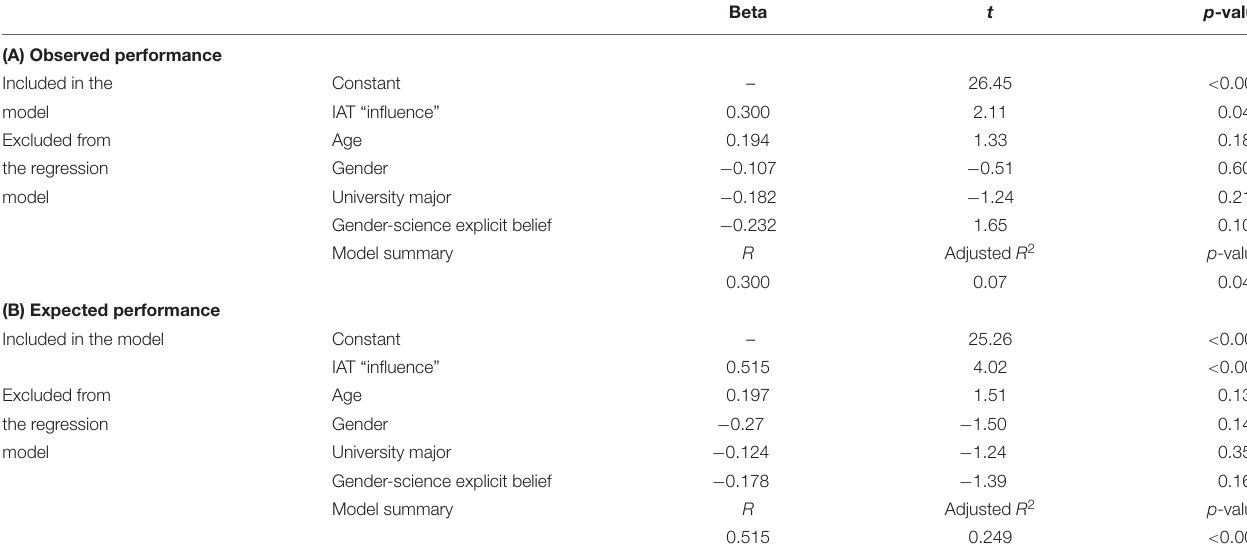
TABLE 4 | Step-forward linear regression of the (A) observed and (B) expected performance of HUM students for the “optimized for men” condition. Beta t p -value